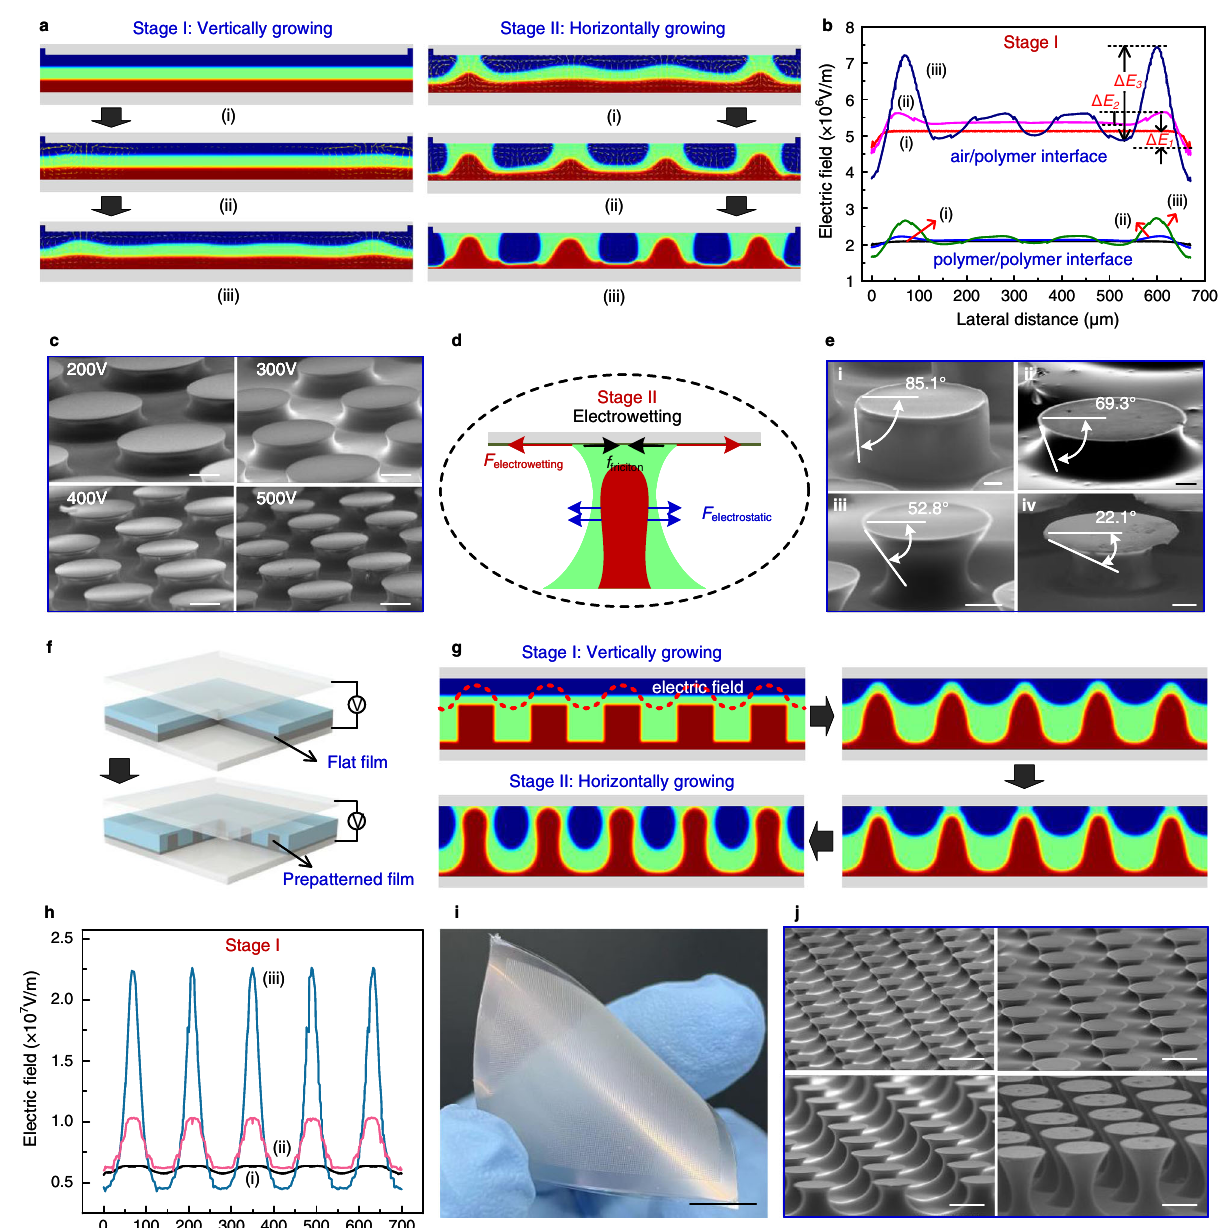
angles,whichcorrespondtodiversevoltages.Thescalebaris50 μ m. f Schematicof the prepatterned bilayer polymer fi lm growth process. g Dynamic evolution of prepatterned bilayer polymer fi lmunderanexternal electric fi eld. The colorsblue, green, and crimson represent air, soft polymer, and rigid polymer, respectively. h Electric fi eld distribution at the air – polymer interface at different snapshots during stage I for the prepattern strategy. i , j Demonstration that these adhesive structures can be grown with a large area using fl exible ITO-coated PET fi lms as conductive substrates ( i ) and different distributions corresponding to distinct prepatterns of the bottom layer ( j ). The scale bars are 1cm and 100 μ m,